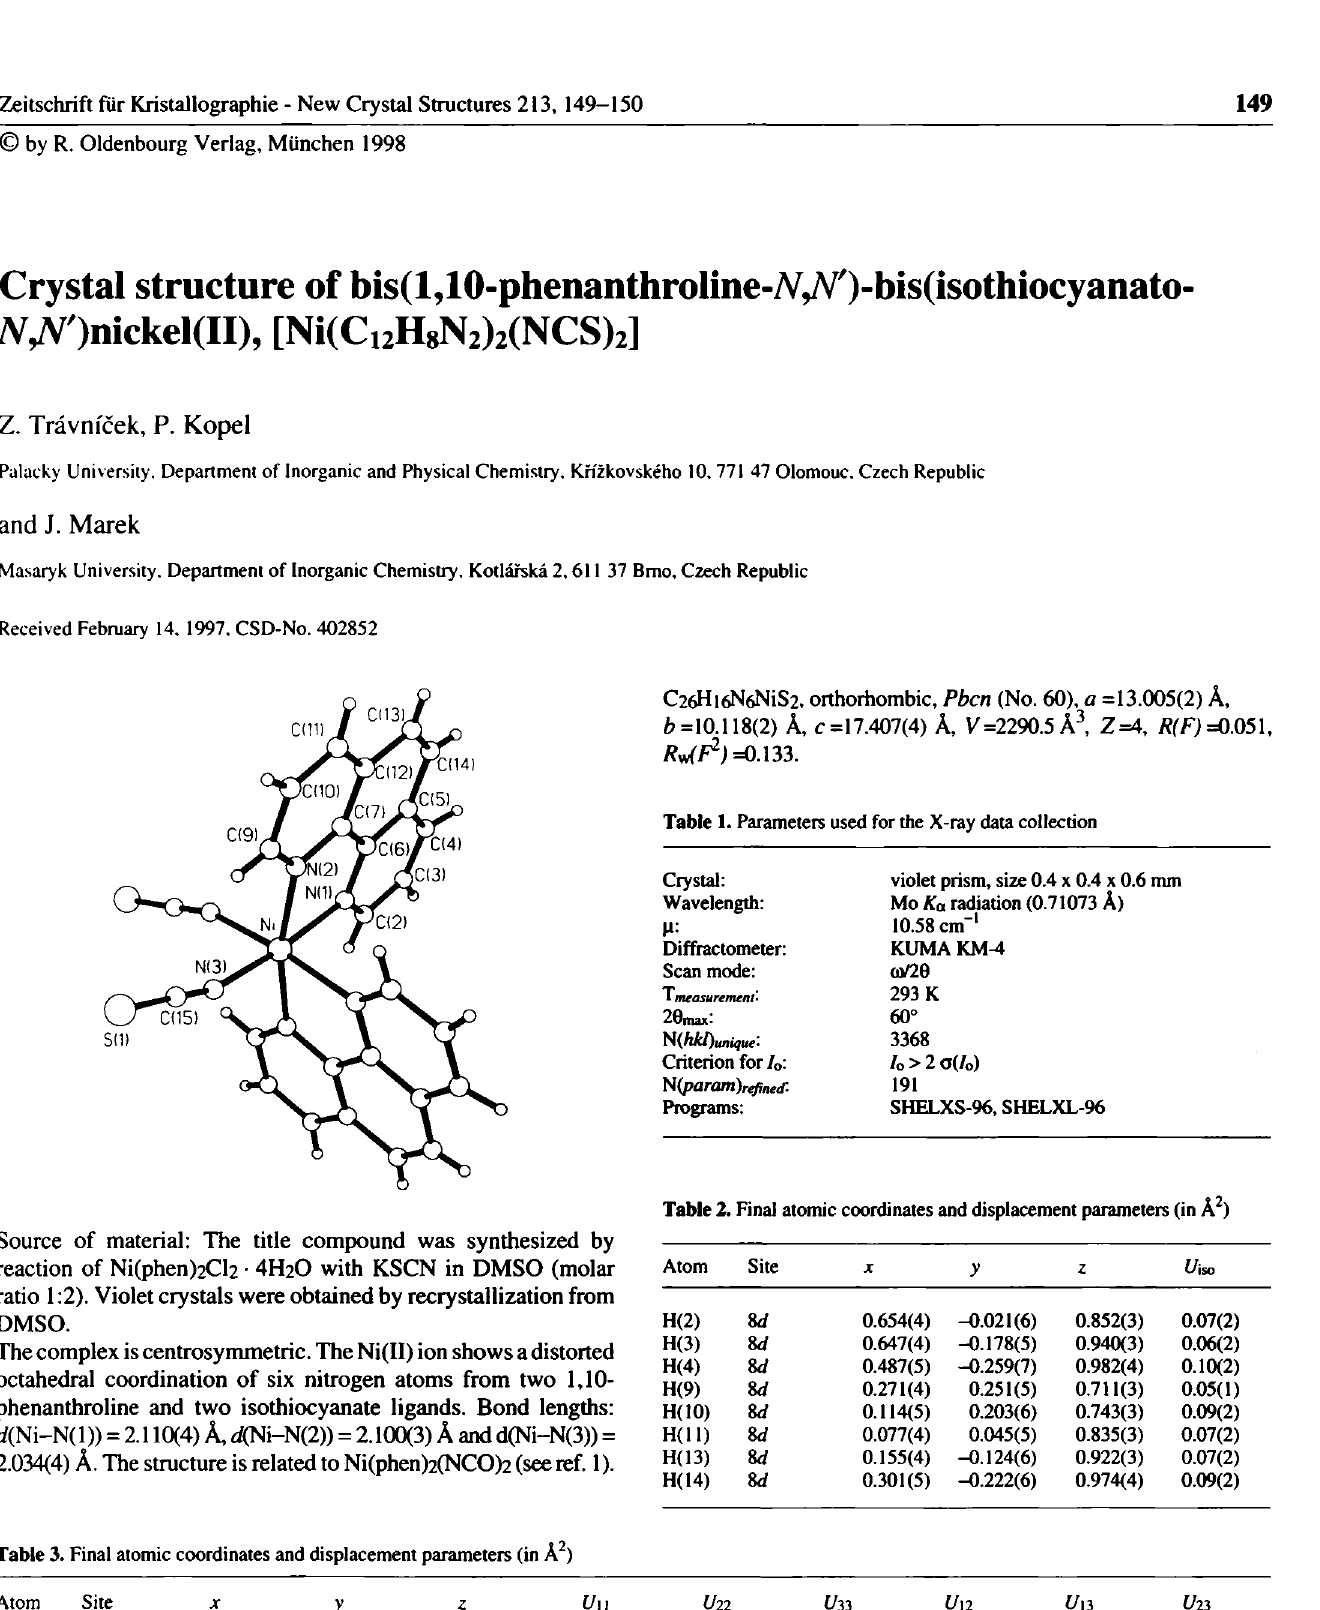
Table 3. Final atomic coordinates and displacement parameters (in